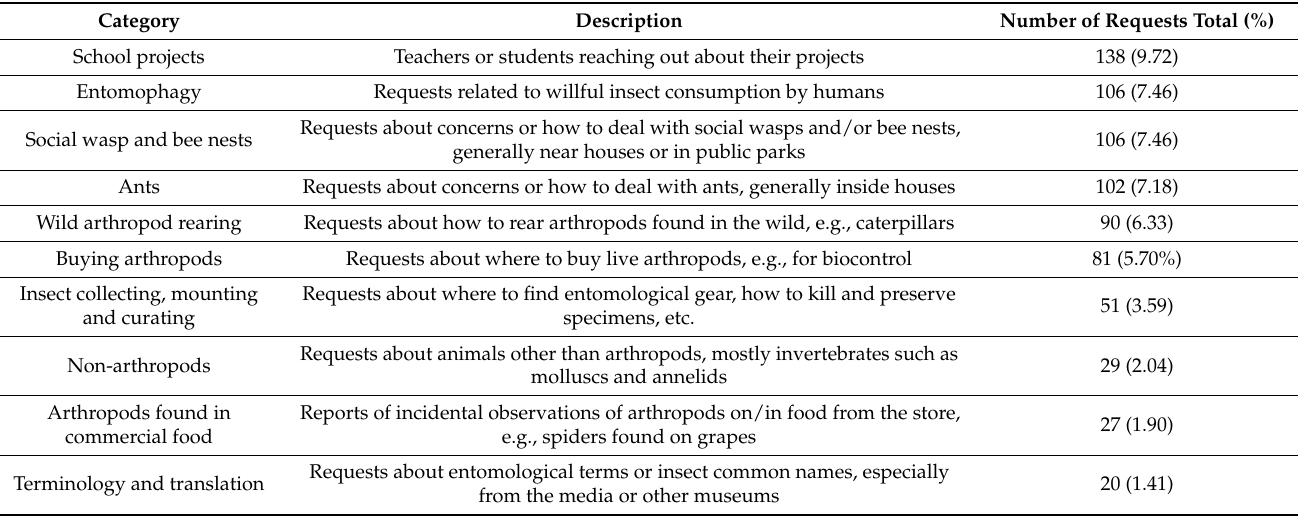
Table 1. Thematic distribution of requests received by the Montreal Insectarium’s Entomological Information Service in 2010, 2011, 2017, and 2018. A given request can be associated with more than one